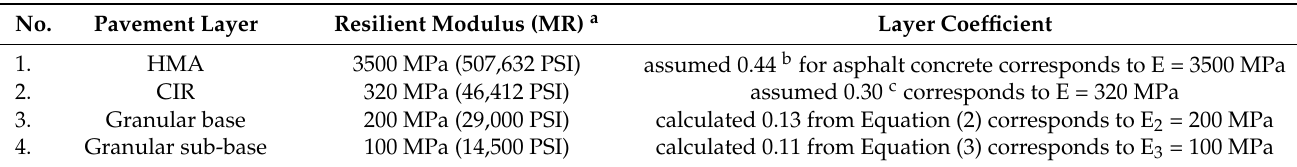
Table 2. Resilient modulus and layer coefficients used in the present